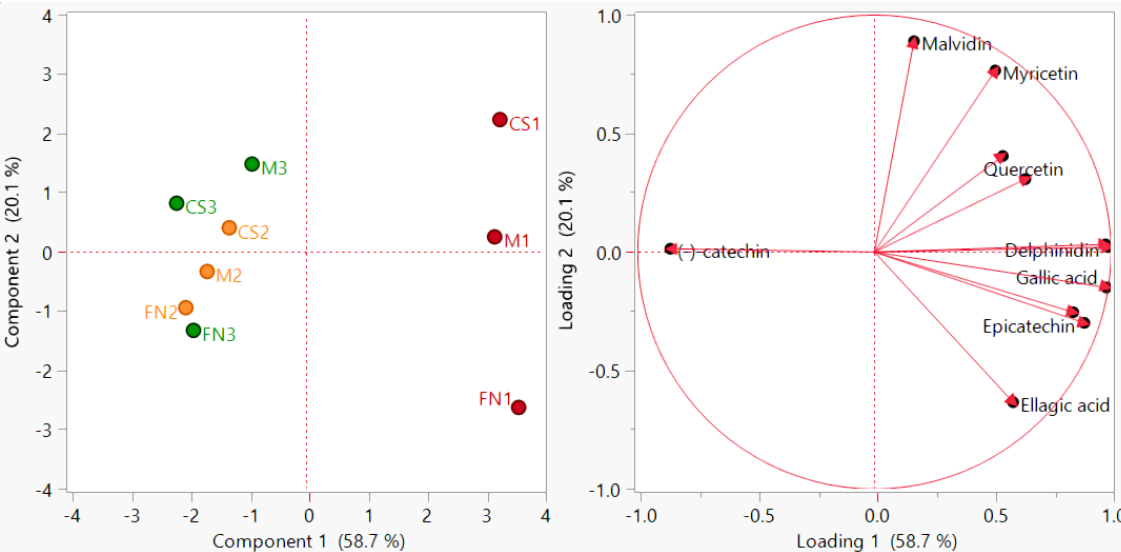
Figure 1. PCA diagram—sample grouping (scores plot) and polyphenol distribution (loadings plot) for Stage 1 wines. Color coding: red—Murfatlar 2014; orange—Murfatlar 2015; green—Valea Călugărească 2015.